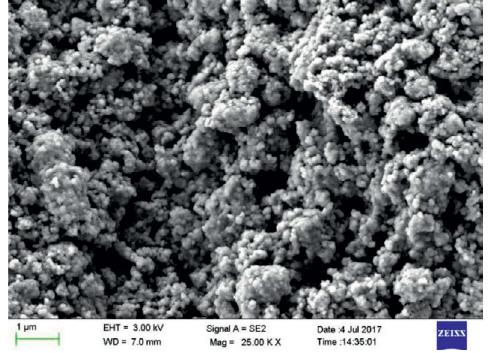
Fig. 1. SEM images of chitosan nanoparticles